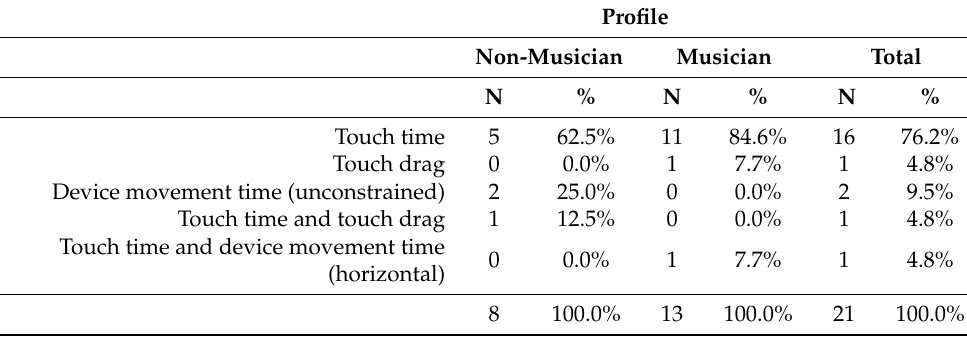
Table A7. Duration variation mapping (uncategorized)—stimulus d.